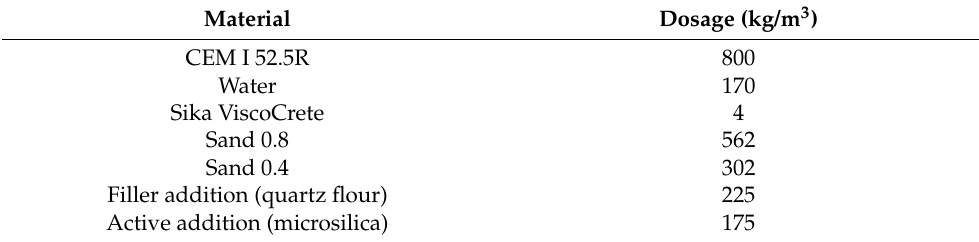
Table 2. Mortar dosages.